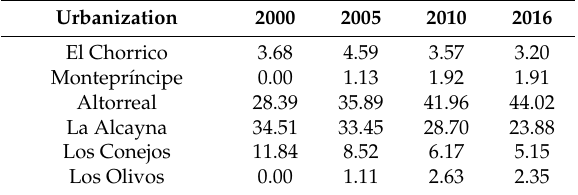
Table 2. Percentage of dwellers in the urbanizations with respect to the total in surrounding